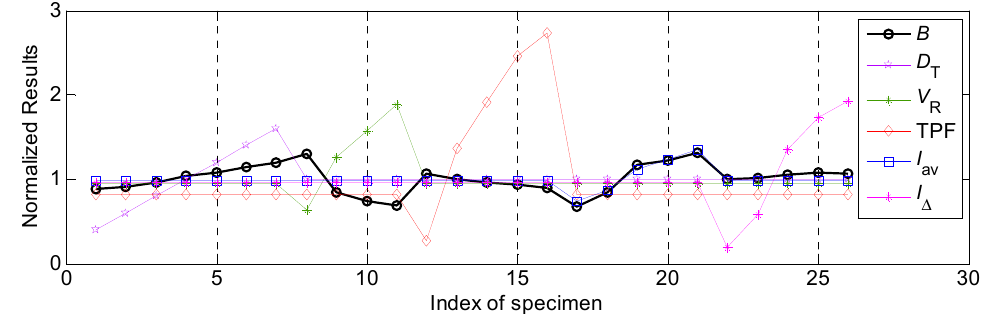
Figure 4. The normalized results of various process parameters and bead width.